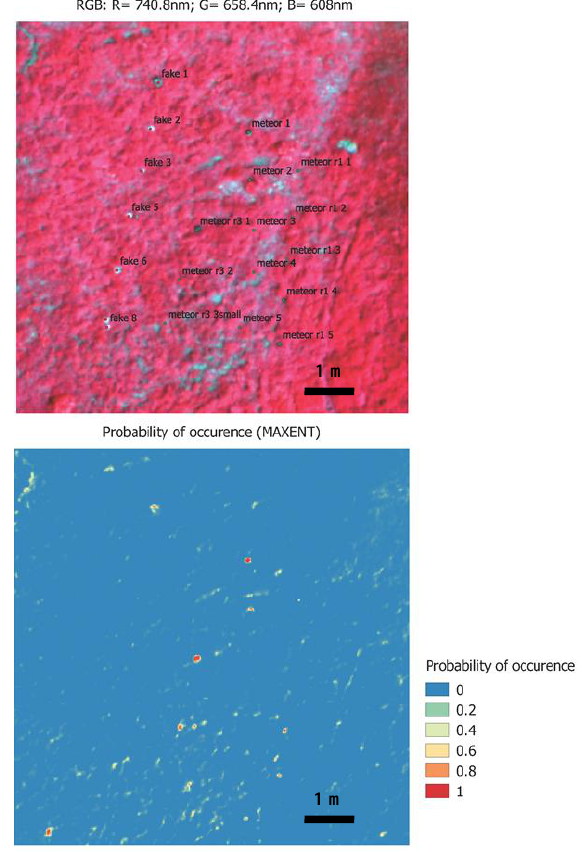
Figure 10. False colour composite (top) showing meteorite and ordinary rock locations and Maxent probability map (bottom) for the meteorite detection on grassland